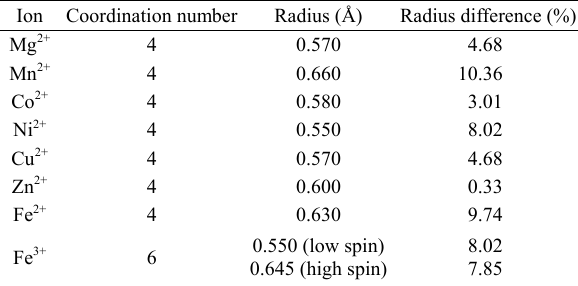
Table 1 Cation radii for the design of HE MFe 2 O 4 (M = Mg, Mn, Fe, Co, Ni, Cu, Zn); the data are obtained from the list of the revised effective ionic radii [39] Ion Coordination